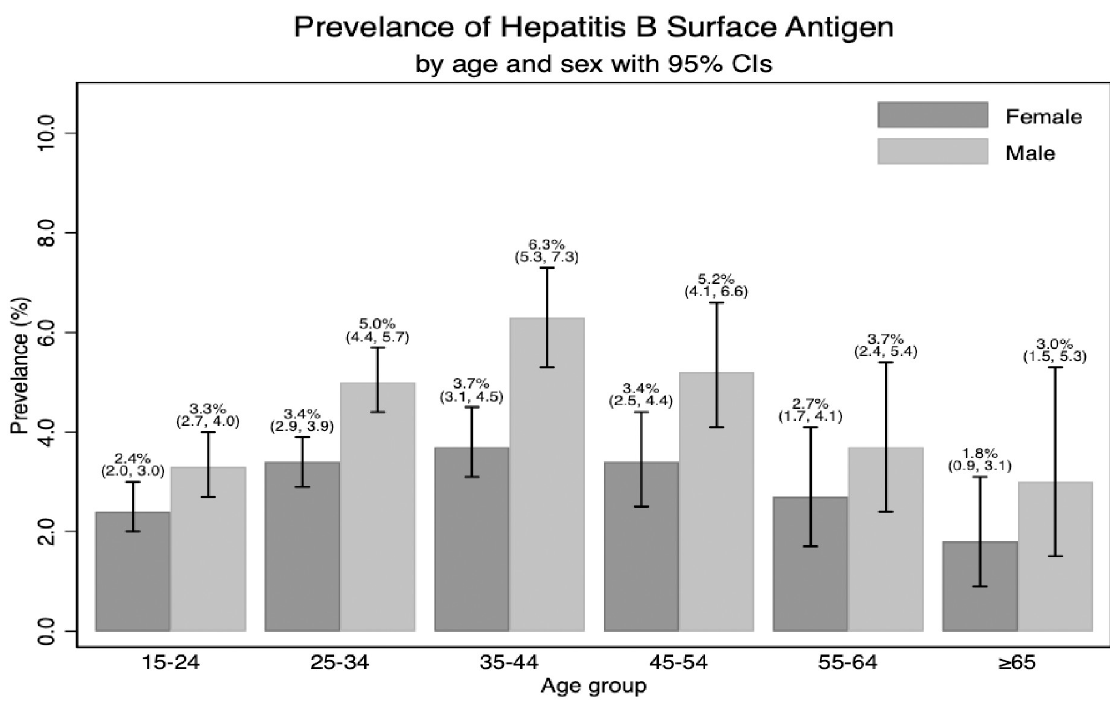
Fig 1. Hepatitis B surface antigen prevalence by age and